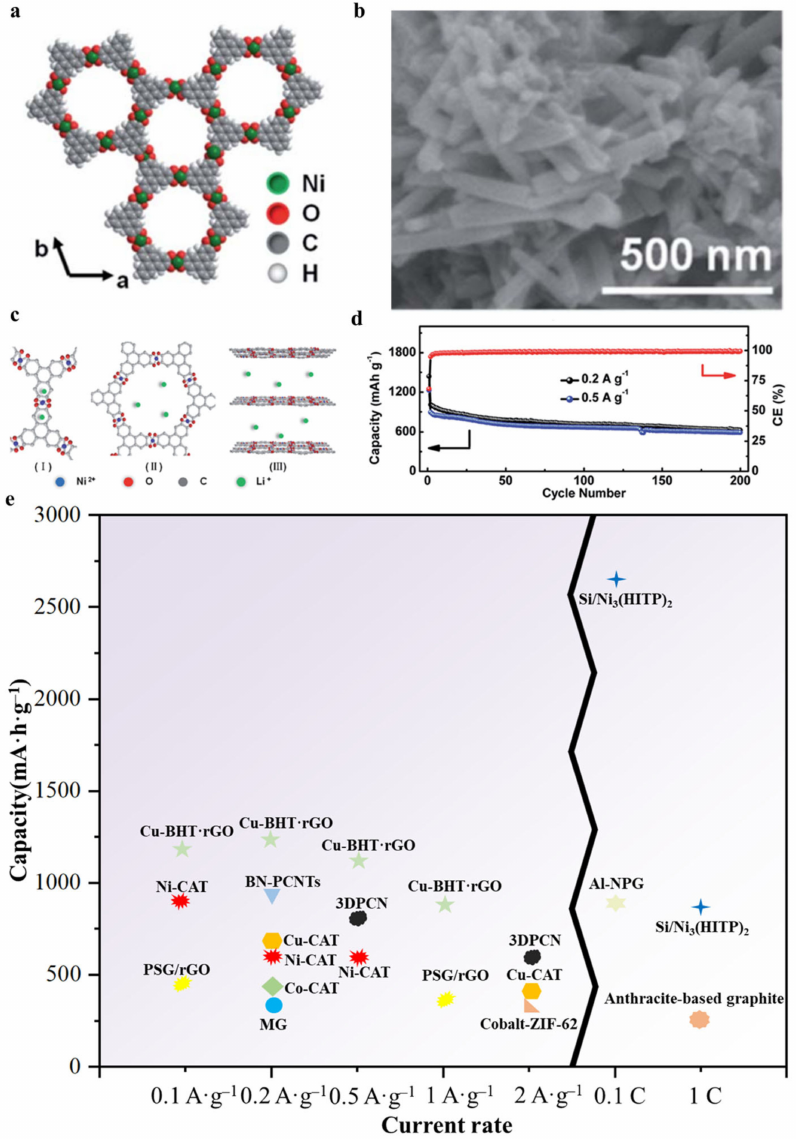
Figure 7. ( a ) Structural model and ( b ) FESEM images of Ni–CAT, ( c ) three lithium storage sites of Ni–CAT located in (I) benzene ring, (II) pores, and (III) space between layers, ( d ) cycling performance of Ni–CAT at 0.2 and 0.5 A · g − 1 . Reproduced with permission from Ref. [77]. Copyright 2019 RSC. ( e ) Comparison of c-MOFs with some conventional carbon-based materials as